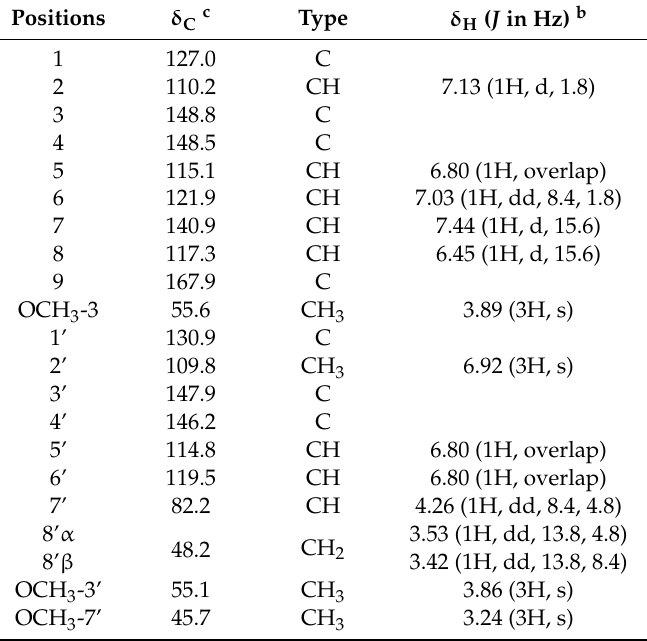
Table 1. Spectroscopic data for compound 8 a in methanol- d 4